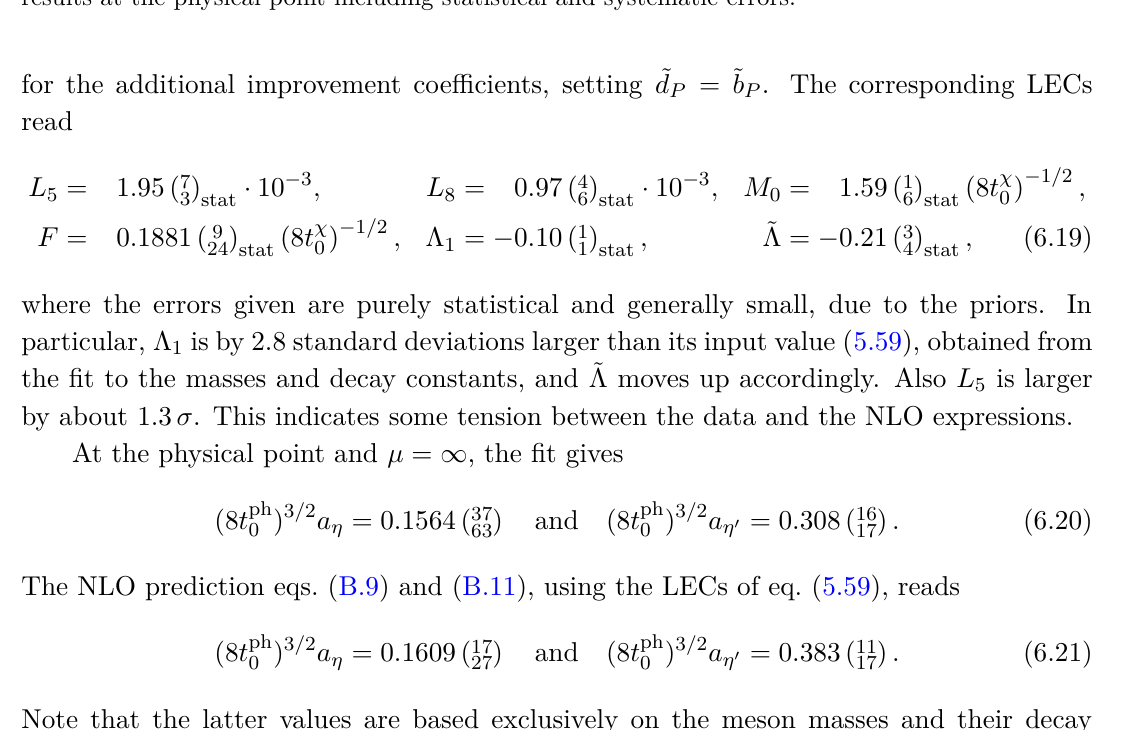
Figure 8. The anomalous gluonic matrix element a η (left) and a η 0 (right) determined via the singlet AWI from fermionic matrix elements, eq. (6.14). The coloured points have been adjusted for lattice spacing effects, while the grey points indicate the unshifted data. The two curves correspond to the NLO large- N c ChPT parametrization eqs. (B.9) and (B.11) for trajectories with a constant average quark mass and a constant strange quark mass. The black error bars indicate the final results at the physical point including statistical and systematic